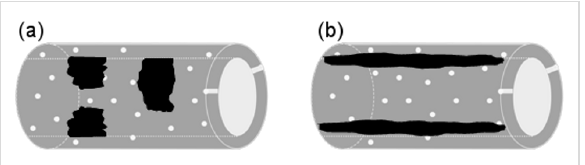
Figure 3: Schematic representation of (a) a plugged and (b) a coated material, obtained by the postsynthetic deposition of zeolite nanoparti- cles into SBA-15. Reprinted with permission from [85]. Copyright 2011 American Chemical